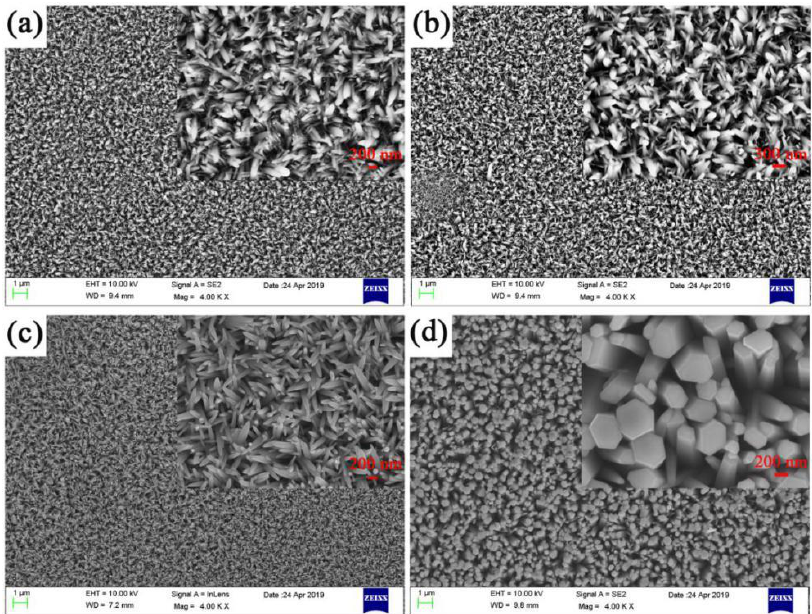
Figure 1. The scanning electron microscopy (SEM) images of ZnO nanorods at di ff erent concentrations, size, and uniformity of ZnO nanorods ( a ) 10 mmol / L (sample 1#), ( b ) 20 mmol / L (sample 2#), ( c ) 40 mmol / L (sample 3#), ( d ) 120 mmol / L (sample 4#).